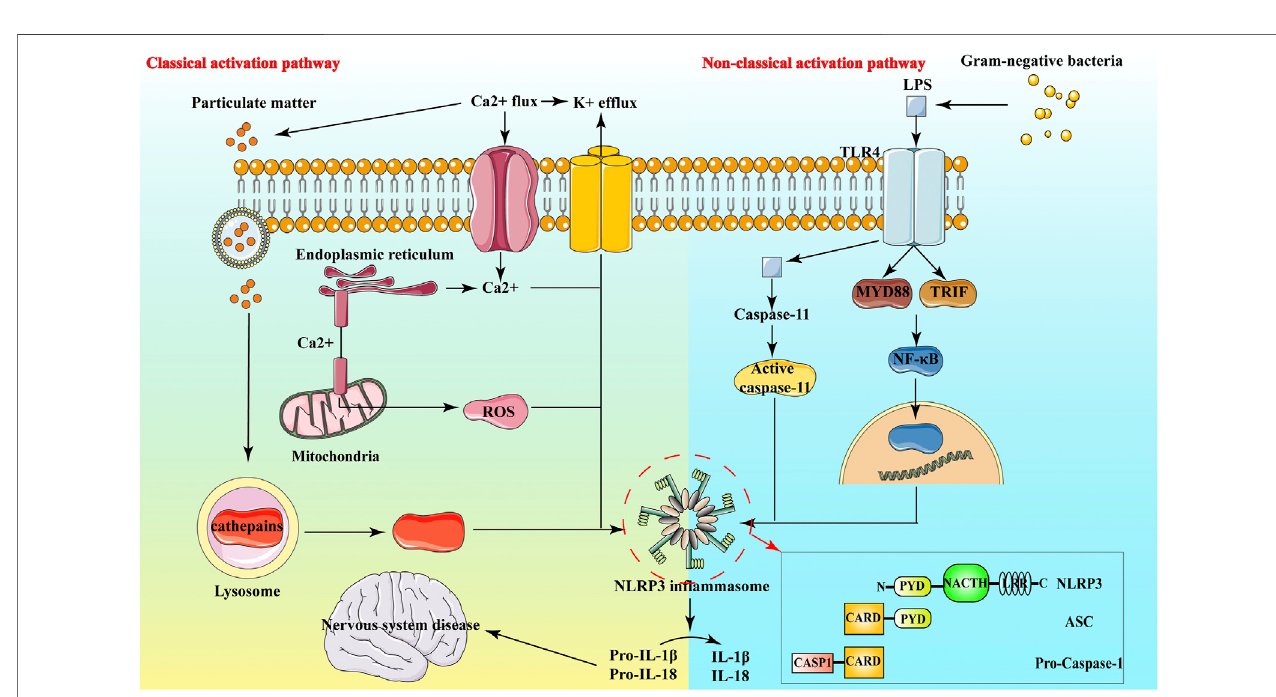
FIGURE 2 | Structure and Activation pathway of